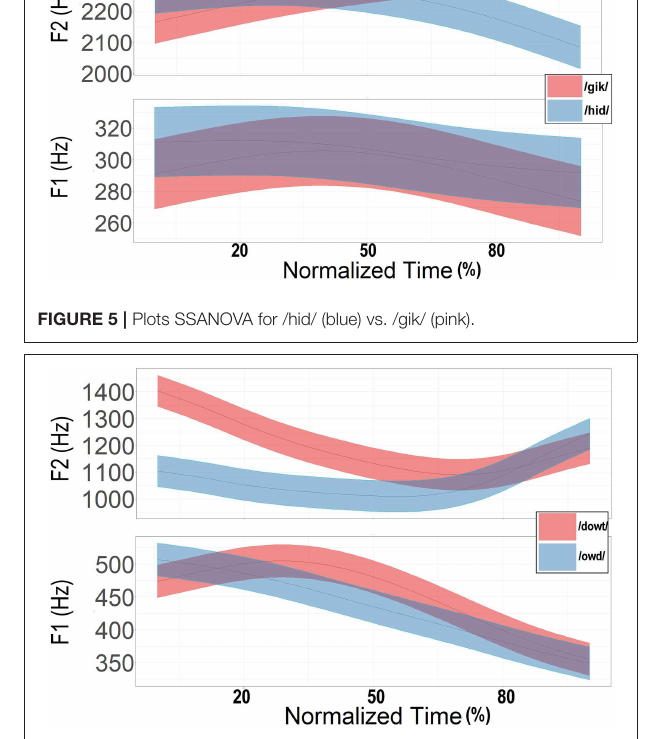
variability is structured by the interactions of the overlapping control parameters of gestures or